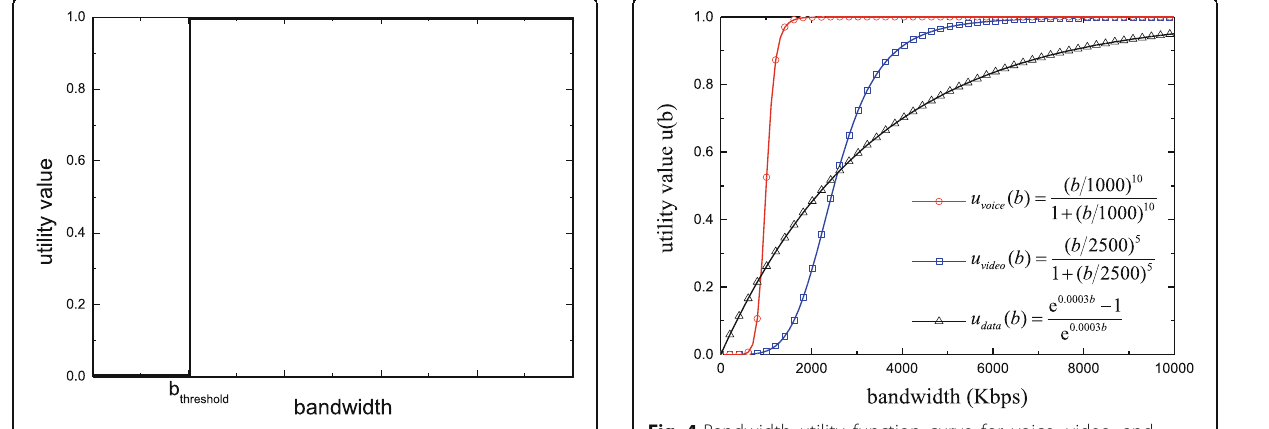
Fig. 4 Bandwidth utility function curve for voice, video, and data applications